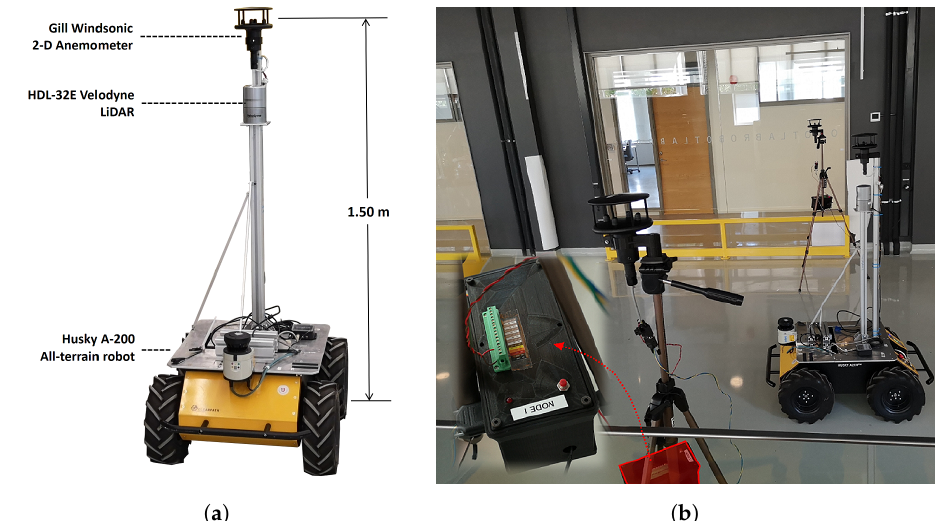
Figure 6. Measurement system used in this paper. ( a ) Mobile robot. ( b ) Sensing